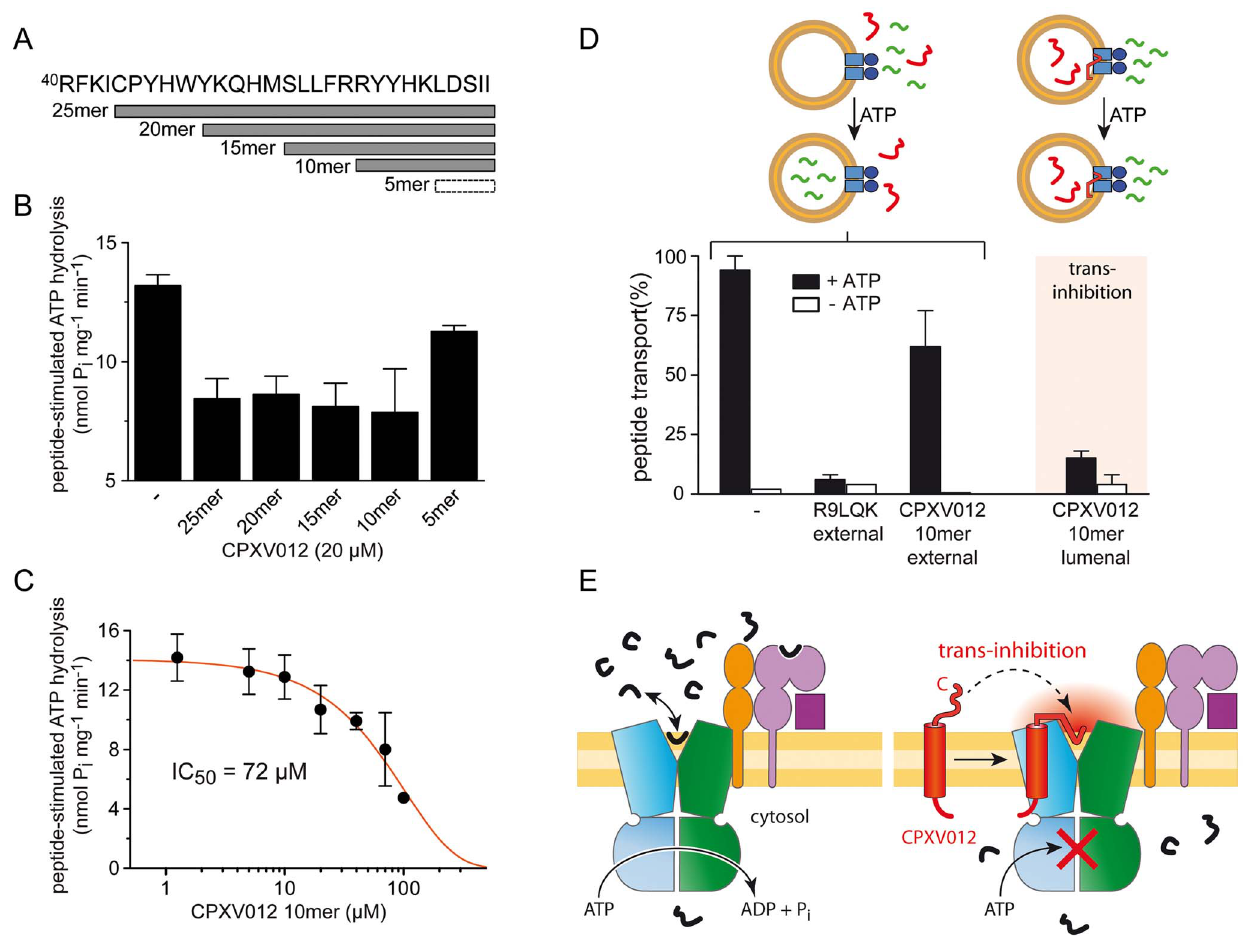
Fig. 6. The ER-lumenal CPXV012 fragment is sufficient for trans-inhibition of antigen translocation. (A) CPXV012 sequence and synthetic peptides derived from the C-terminal ER-lumenal end of CPXV012. (B) The C-terminal 10 residues of CPXV012 are sufficient for inhibition of the peptide-stimulated ATP hydrolysis of TAP. Purified coreTAP (0.2 m M) was incubated with ATP (1 mM) and high-affinity substrate peptide R9LQK (1 m M) in the presence and absence of C-terminal CPXV012 peptides (20 m M) as indicated. Release of inorganic phosphate was quantified and normalized to the coreTAP-dependent hydrolysis in the presence of R9LQK. Each data point represents the mean of triplicate measurements. Error bars show S.D. (C) The ATP hydrolysis activity of purified TAP (0.2 m M) was measured in the presence of ATP (1 mM), substrate peptide R9LQK (0.5 m M), and increasing concentrations of CPXV012 10mer-peptide. By fitting of the data, a half-maximum inhibition value (IC 50 ) of 72 6 20 m M was determined. (D) 10mer CPXV012 fragment blocks peptide translocation in vitro . Transport of RRYC (F) KSTEL peptide (1 m M; C (F) , fluorescein-labeled cysteine) by reconstituted coreTAP was analyzed in the presence and absence of ATP (3 mM) in combination with 100 m M unlabeled peptide R9LQK or CPXV012 10mer-peptide added to or entrapped in liposomes (external and lumenal, respectively). (E) Inhibition mechanism of CPXV012. TAP transports peptides until a critical concentration inside the ER lumen induces trans-inhibition of the transport complex.